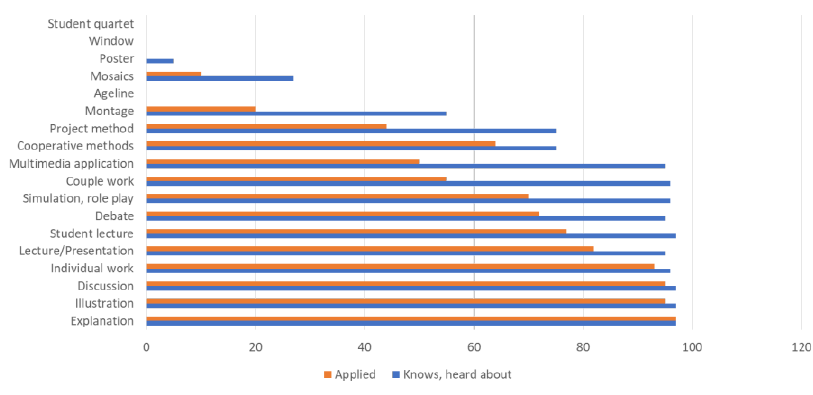
Fig. 1. Knowledge and application of teaching